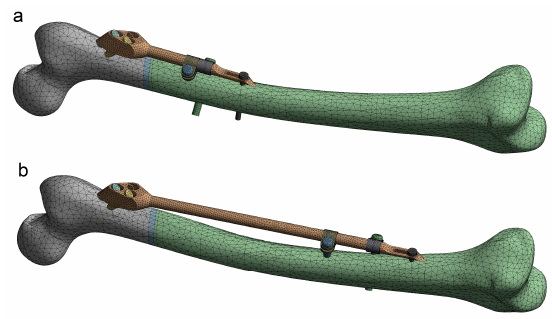
Figure 9. Instances of the femur–SIF FE model (only two instances are shown, as the others are similar). ( a ) Bar length 100 mm, clamp spacing 1 mm. ( b ) Bar length 250 mm, clamp spacing 28 mm.